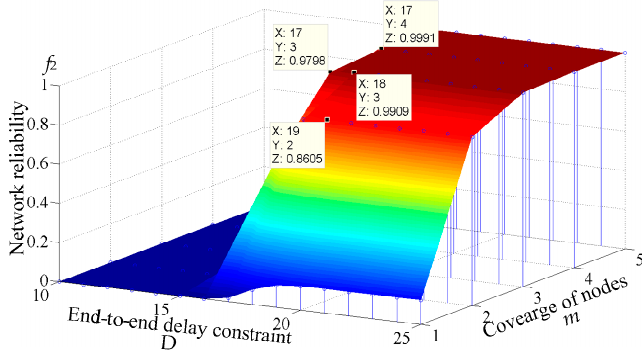
Figure 8. Effect of end-to-end delay constraint.